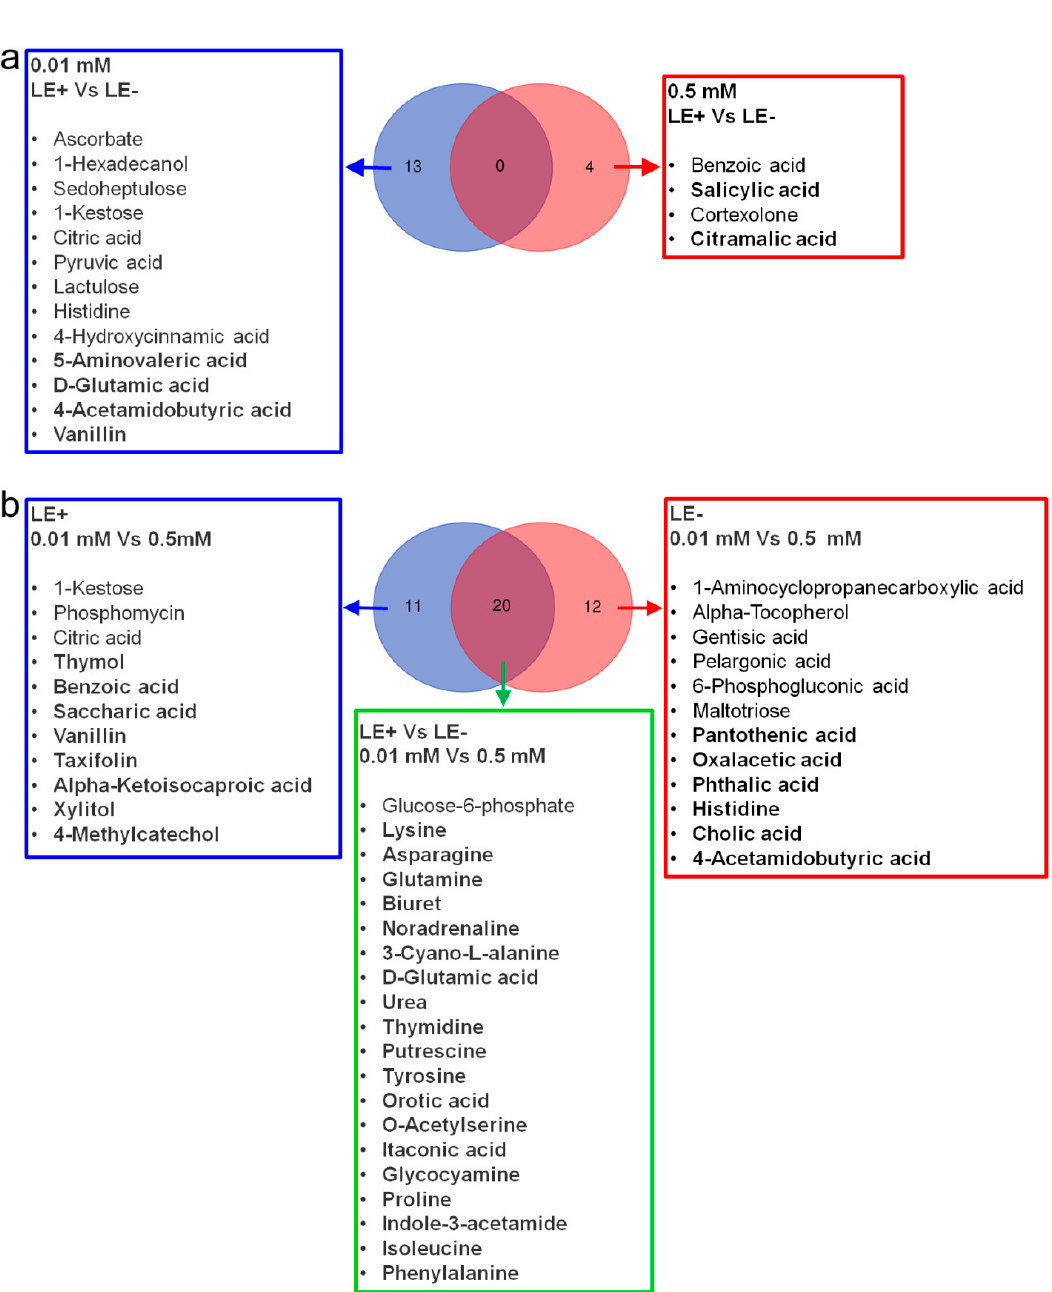
Figure 6. Venn diagram showed the significant difference of metabolites between LE+ and LE − at 0.01 and 0.5 mM P ( a ), between 0.01 and 0.5 mM P in LE+ and LE − ( b ).